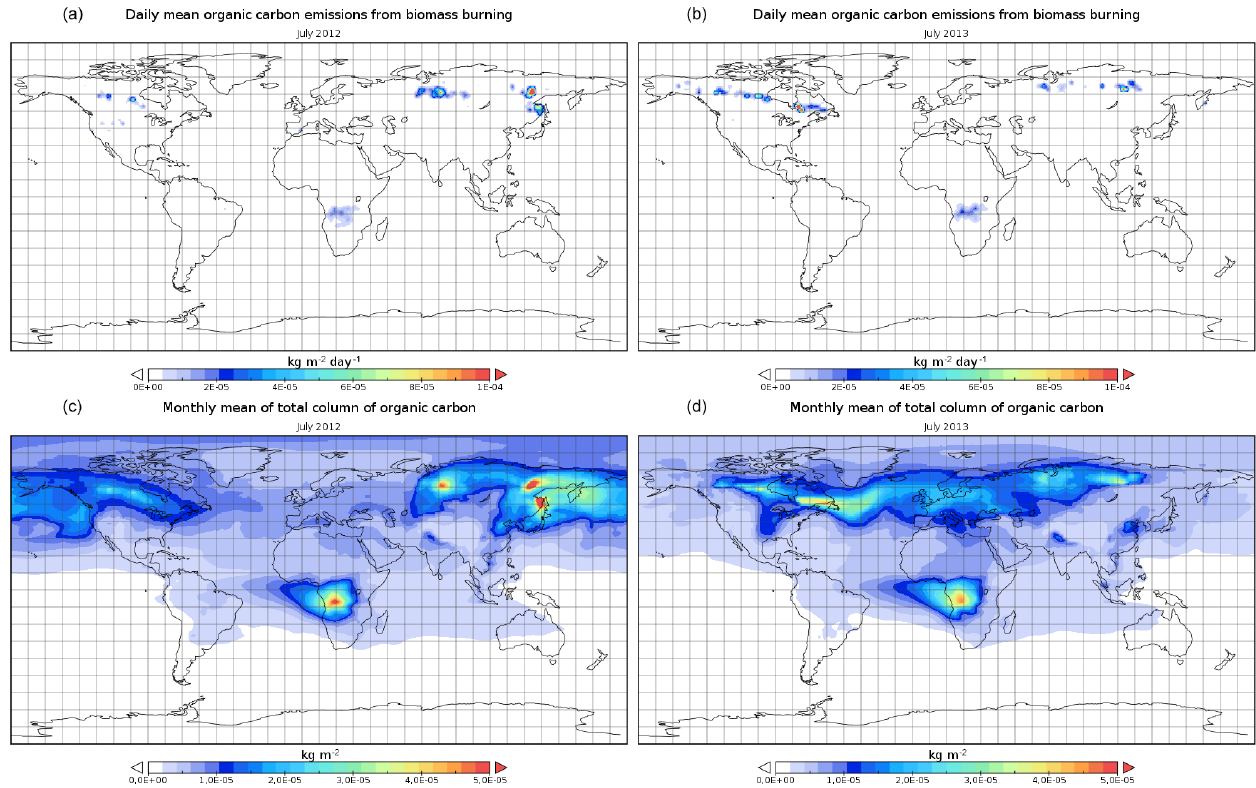
Figure 9. Maps of organic carbon emission from biomass burning (a, b) and total column of primary organic carbon aerosols (c, d) for July 2012 (a, c) and July 2013 (b, d)